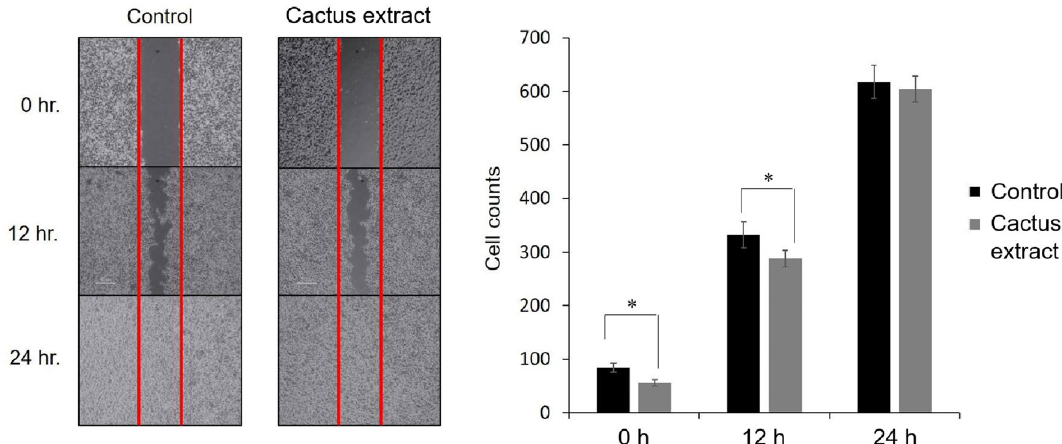
Figure 8. Wound healing assay to determine cell migration treated with cactus extract (flesh) by B16-F10 cells.